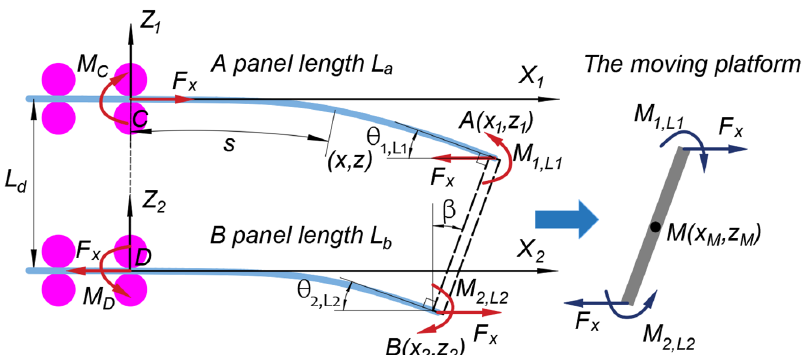
Figure 2. Analysis model without gravity ( Fx is the pushing force constrained along the X 1 axis and imposed at point C , M 1, L and M 2, L are moments generated by the bending of top panel A and MC and MD are the reaction moments).